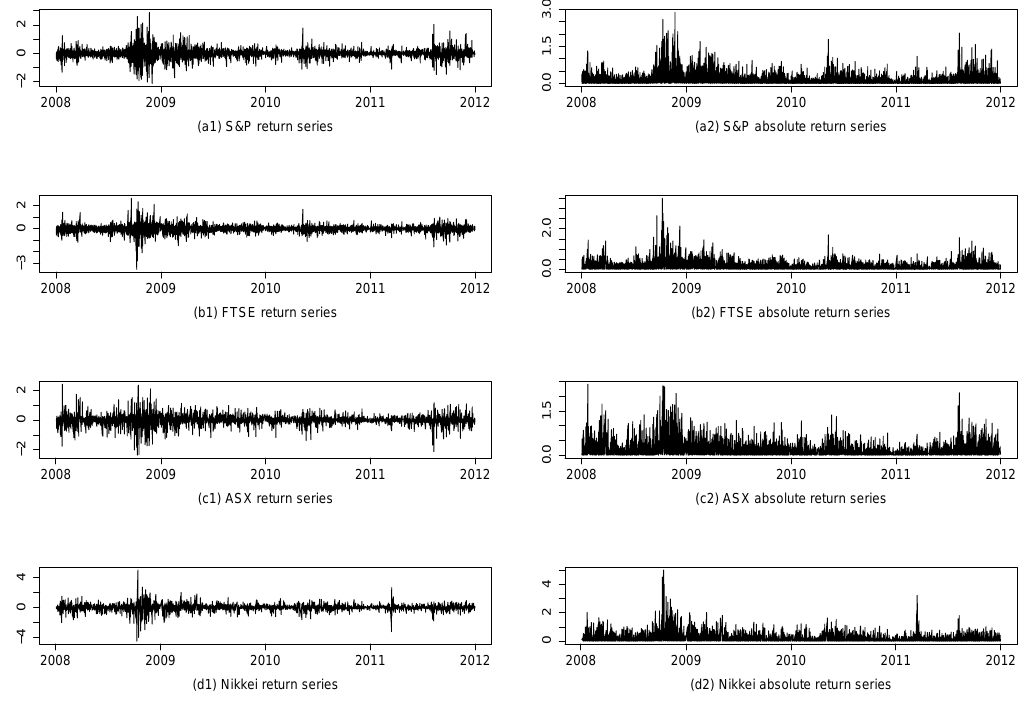
Figure 3. Hourly returns and hourly absolute returns for stock indexes from 1 January 2008 to 31 December